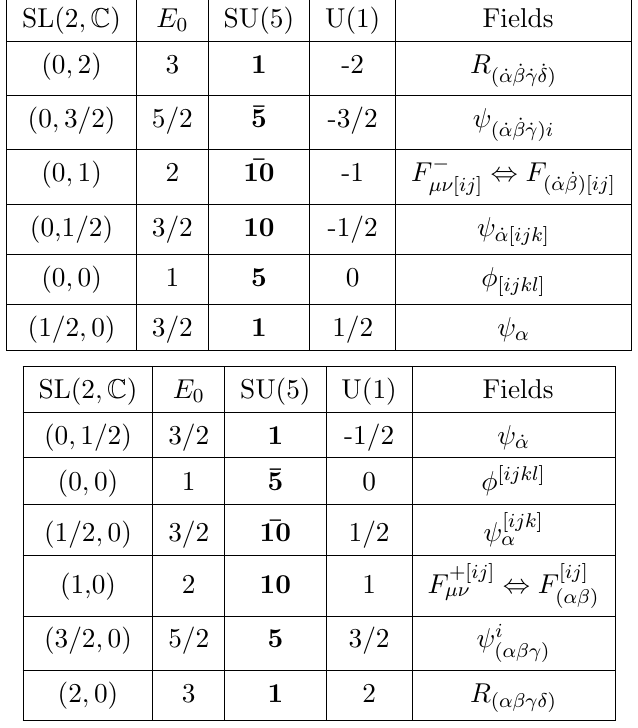
Table 3 . The irreducible chiral doubleton supermultiplet of SU(2 ; 2 j 5) and its conjugate corre- sponding to the N = 5 supergravity